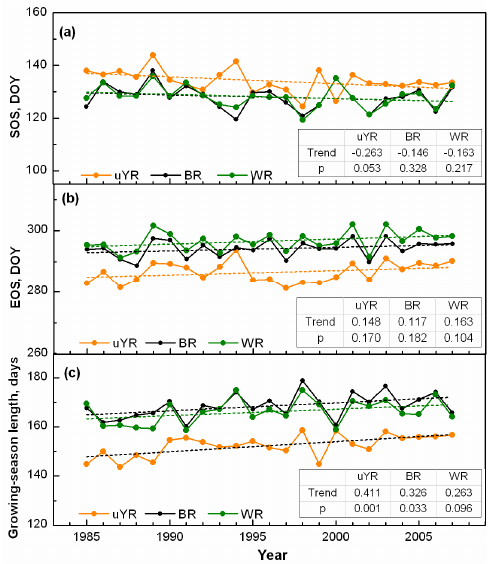
Figure 4. The means and trends (day·year − 1 ) of three freeze-thaw metrics based on the satellite FT-ESDR dataset [35] during the period from 1985 to 2007: ( a , b ) means (the day of year, DOY) and trend (day·year − 1 ) of primary thaw day in the spring ( i.e ., the timing when the surface begins to thaw); ( c , d ) means (DOY) and trend (day·year − 1 ) of primary frozen day in the fall ( i.e. , the timing when the surface begins to freeze); and ( e , f ) mean (days) and trend (day·year − 1 ) of annual non-frozen period ( i.e. , the number of days between primary thaw and frozen dates).